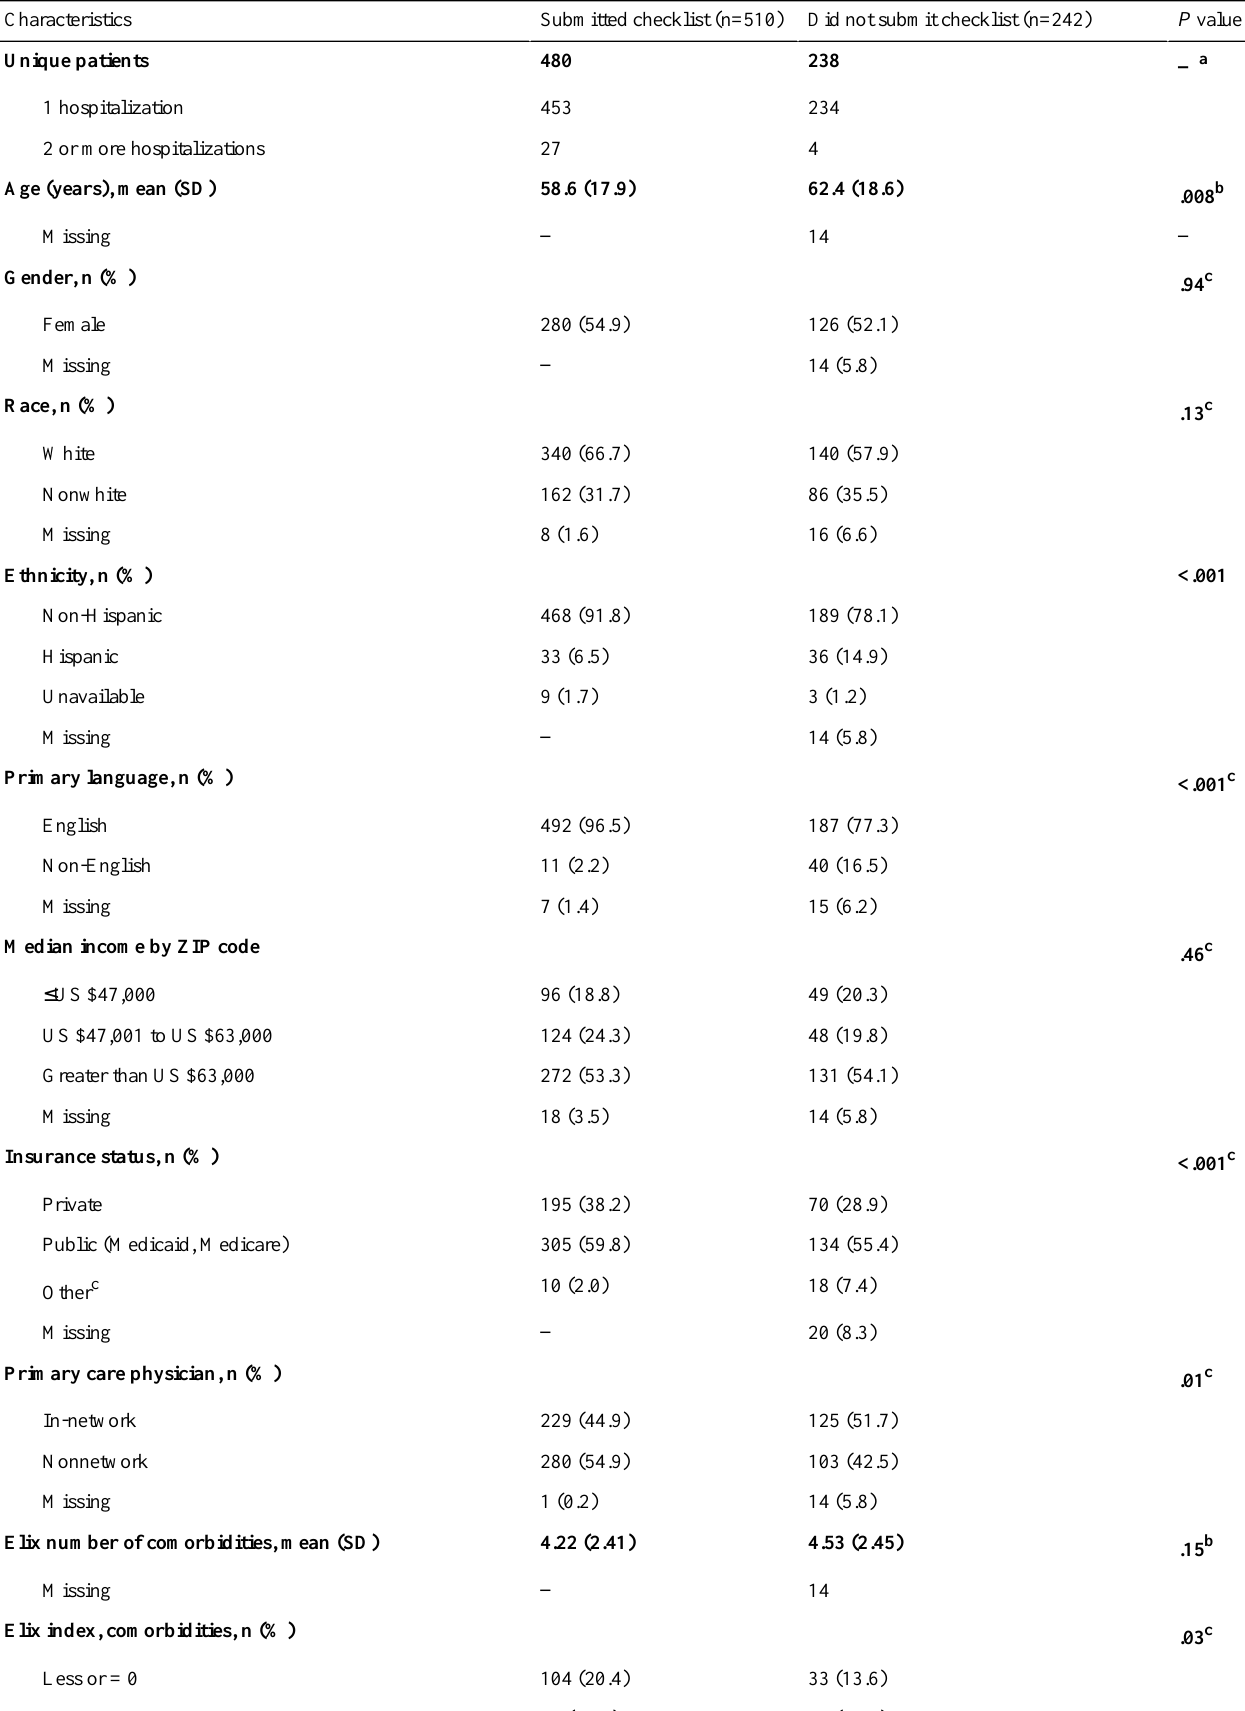
Table 3. Demographics of patient admissions